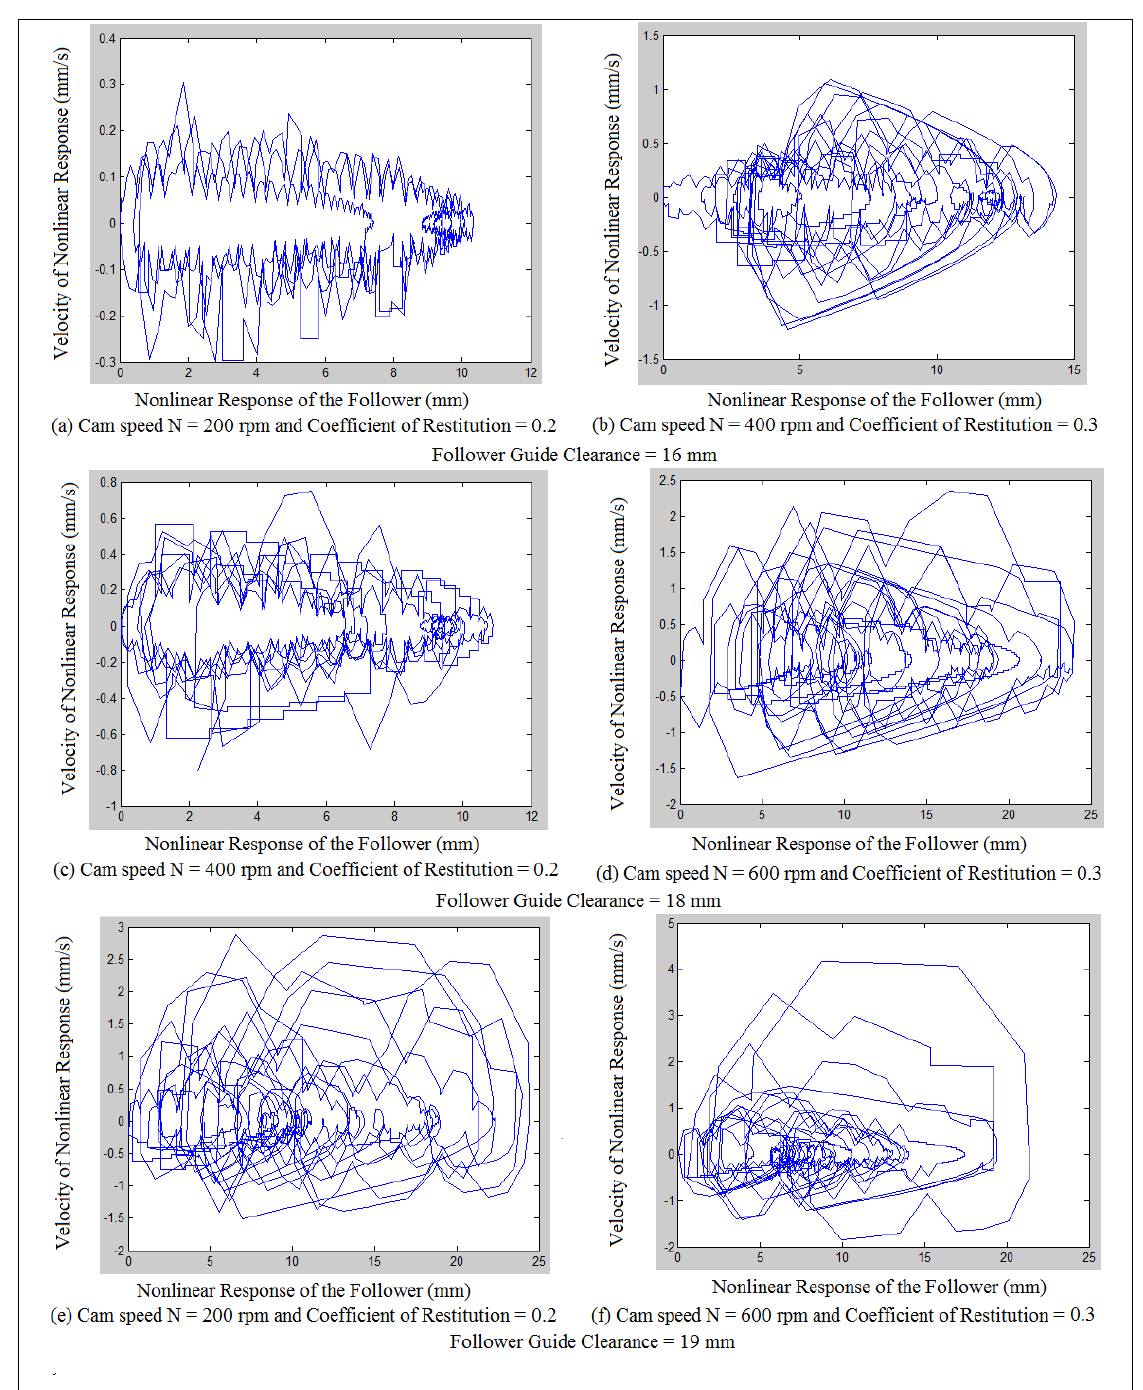
Figure 20. Phase-plane mapping of nonlinear response of the follower when the follower offsets to the right at (O = 30 mm).